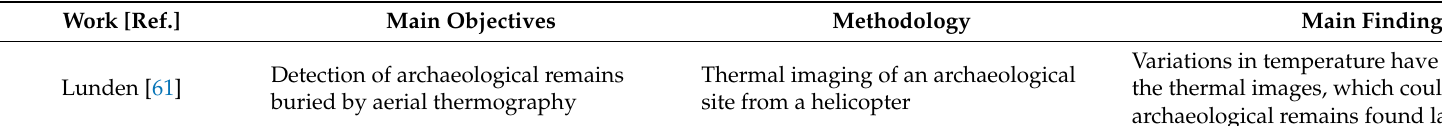
Table 3. Review of IRT studies in heritage